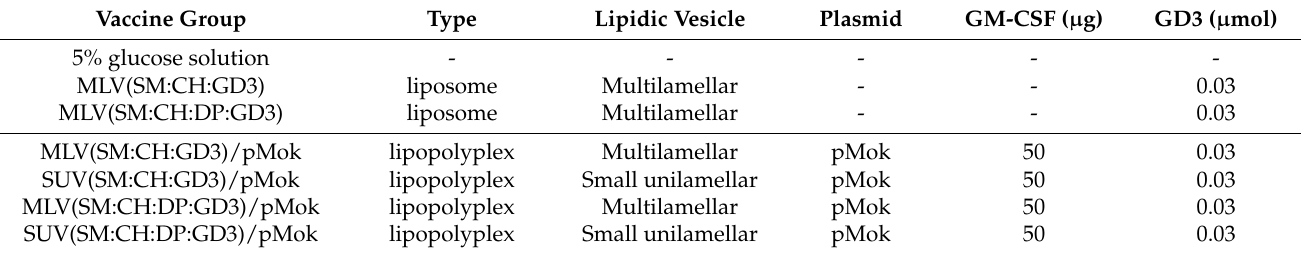
Table 2. Immunization assay groups with the multicompartmental lipopolyplex loaded with lipidic antigens (GD3). Vaccine Group Type Lipidic Vesicle Plasmid GM-CSF ( µ g) GD3 ( µ mol) 5% glucose